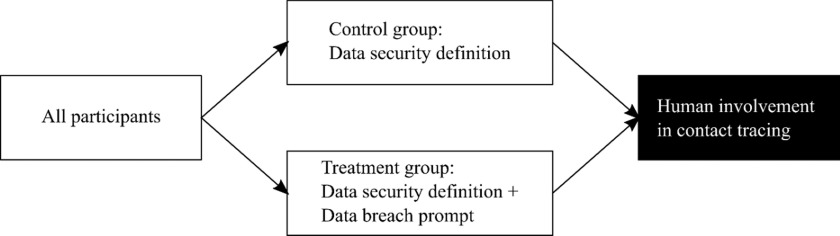
Overview of Study 2.